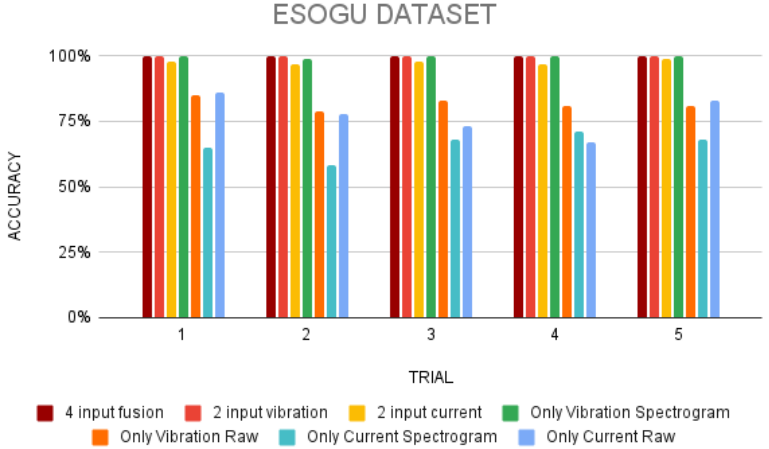
Figure 10. ESOGU dataset comparison with different methods.